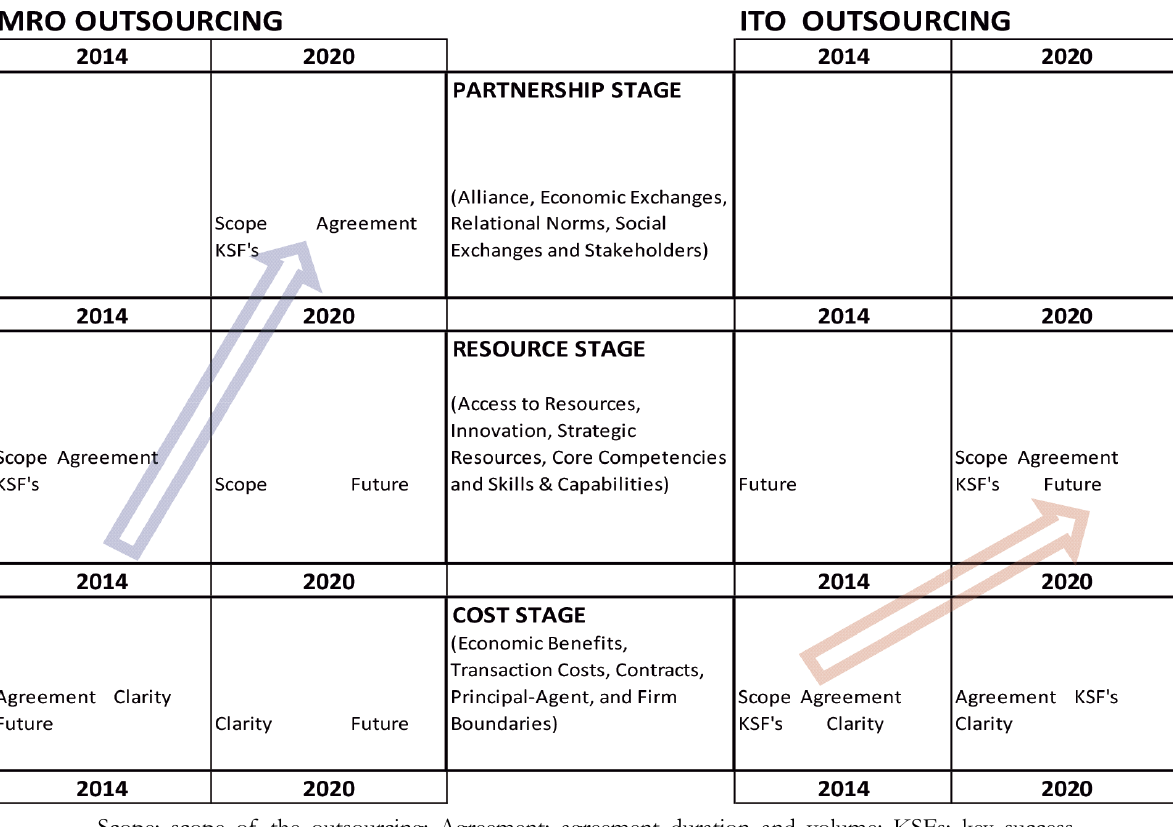
Figure 4. MRO and ITO interview results combined with schematic trend